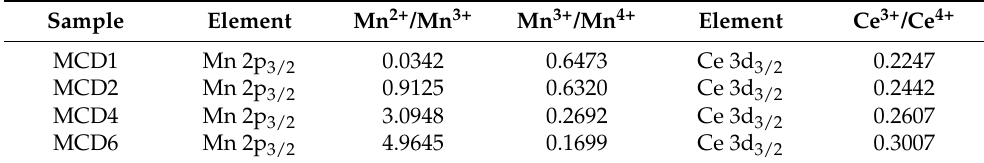
Table 1. The quantitative analysis of valence states of the main elements.